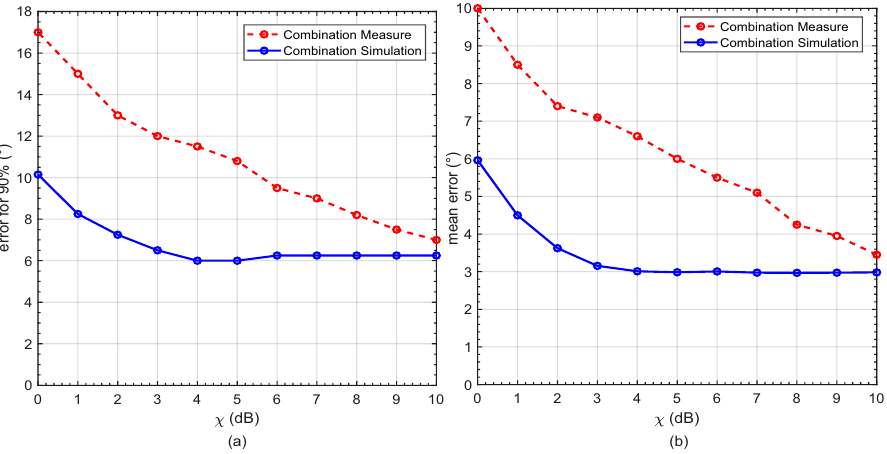
Figure 18. Comparison for D = 2.5 m between measurement and simulation environment of 90-th percentile combined DoA estimation error ( a ) and Mean combined DoA estimation error ( b ).